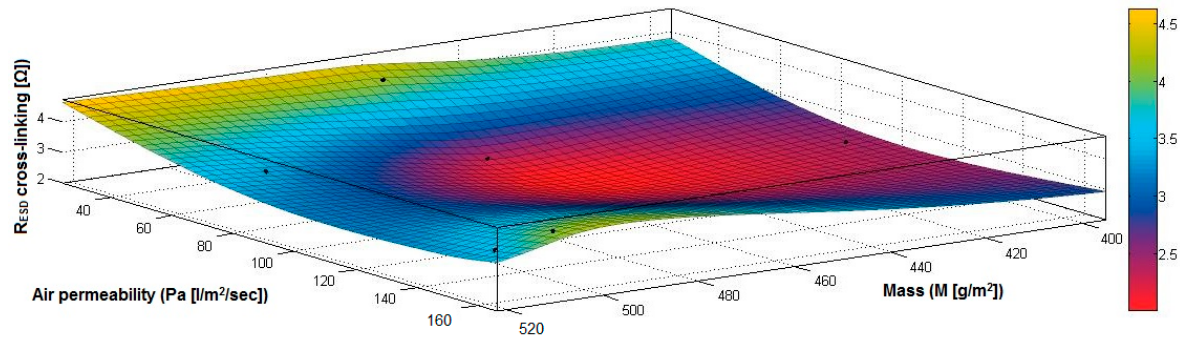
Figure 41. 3D representation R ESD after crosslinking = f(Pa, Pv) samples preliminarily treated in RF plasma O 2 using RF 2 generator and power 50 W.